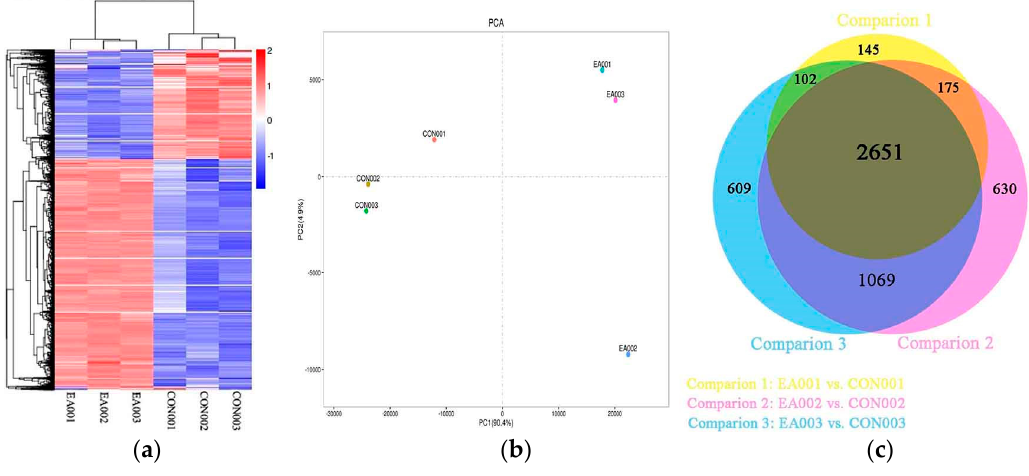
Figure 2. Overview of differentially expressed genes (DEGs). ( a ) Hierarchical clustering; ( b ) Principal component analysis; ( c ) An Venn diagram of DEGs. CON001, CON002 and CON003 were control groups. EA001, EA002 and EA003 were EA groups. Samples from same numbers were twin goats’ the periaqueductal gray.